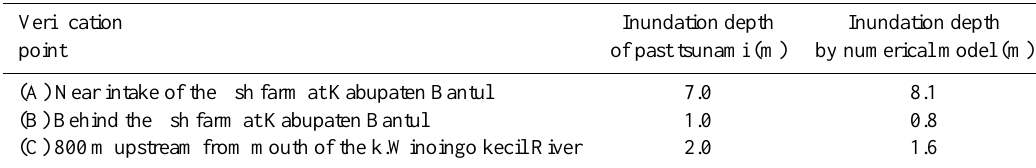
Table 3. Comparison of inundation depths of past tsunami and numerical model.